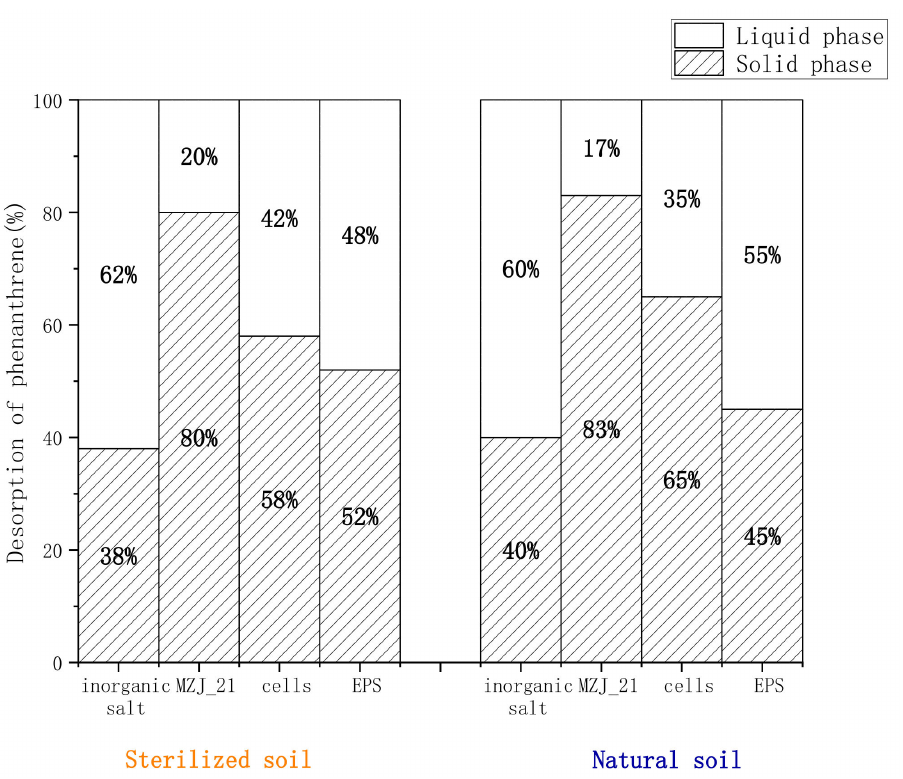
Figure 3. Distribution proportion of phenanthrene in the liquid and solid